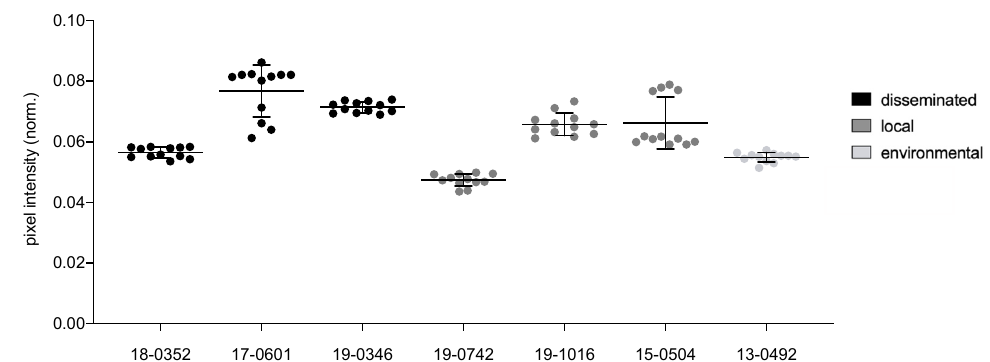
Figure 1. Melanization of C. neoformans var. neoformans isolates. Five µL containing 10 6 cells were spotted on Niger seed agar and incubated at 30 °C for 48 h. Plates were photographed and converted to black/white pictures. The pixel intensity of the colonies was measured digitally. Measurements were normalized by division through the sum of all measured pixels. Therefore, lower values of normalized pixel intensity indicate stronger melanization. Black lines show means with standard deviation of three biological replicates with five measurements each. Dots show individual data points.